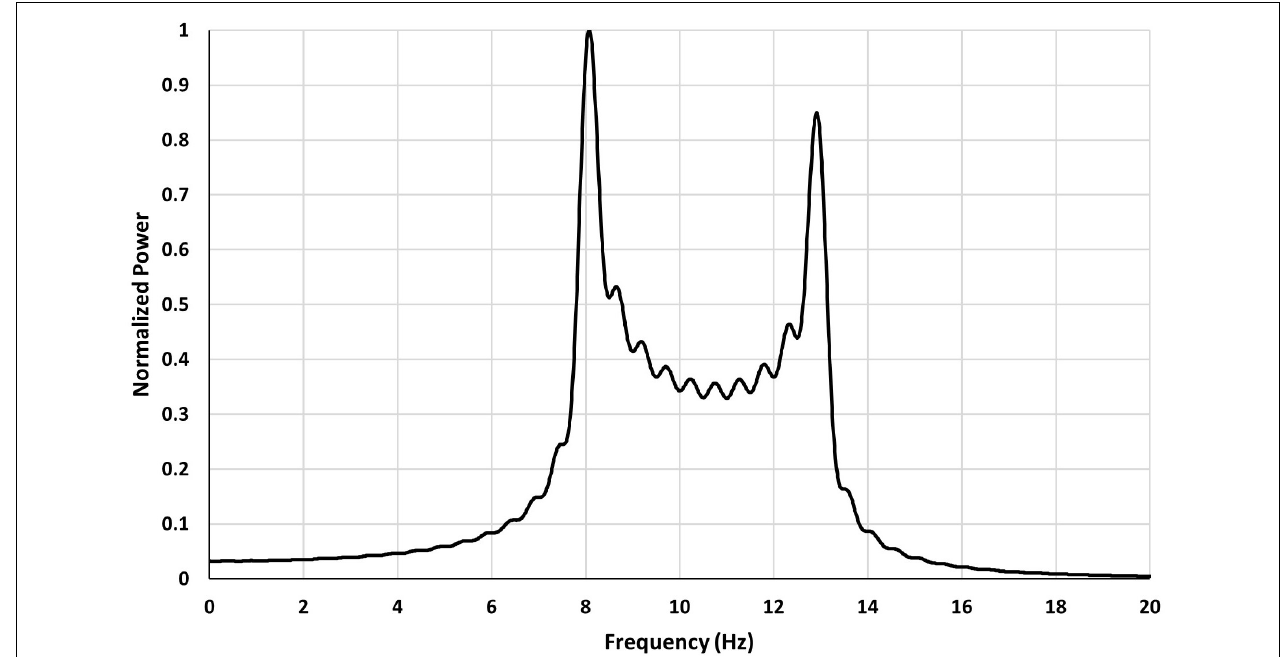
FIGURE 2 | Power spectrum of F for a signal with a frequency band in the range 8–13 Hz and a signal window of 2 s.